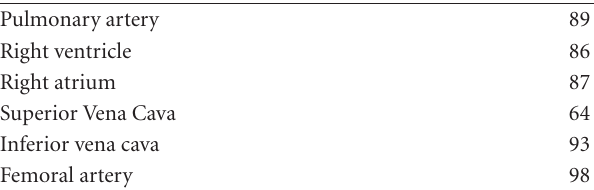
Table 2: Oxygen saturation (%) measured during cardiac catheter- ization.